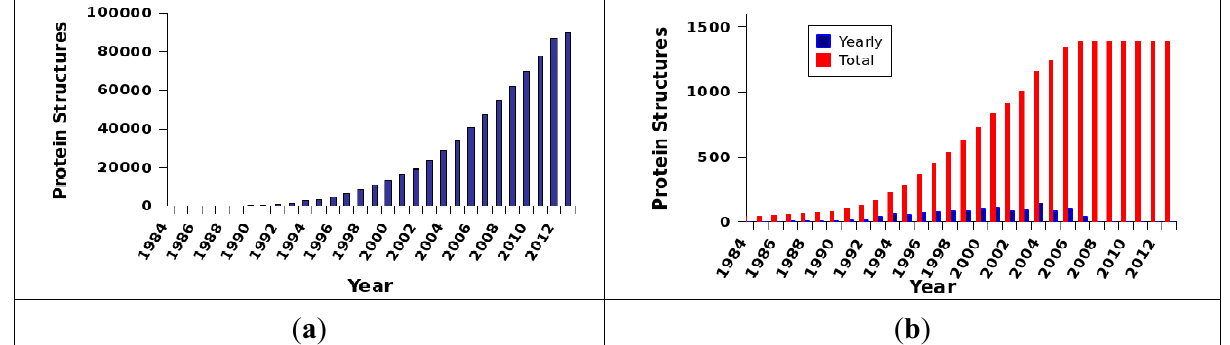
Figure 1. Number of protein structures in PDB ( a ) cumulative since 1974 and ( b ) unique folds reported by